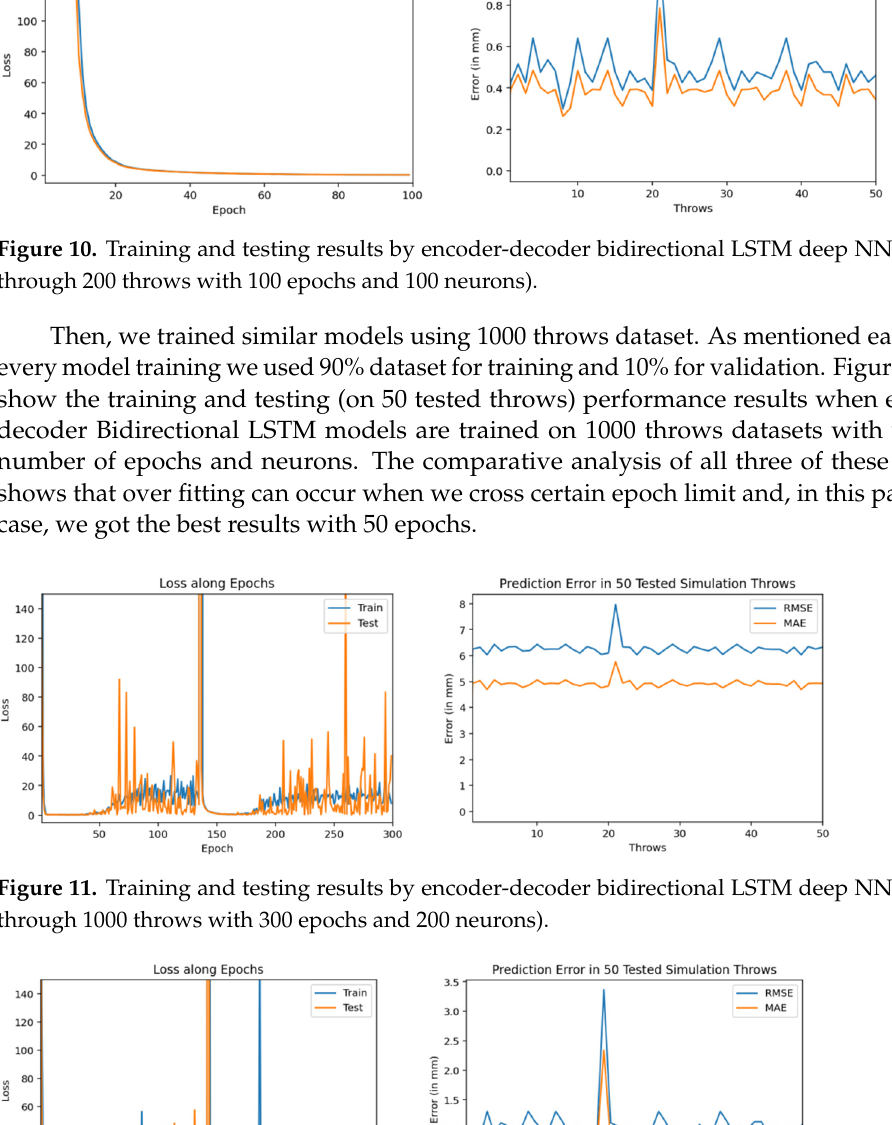
Figure 13. Training and testing results by encoder-decoder bidirectional LSTM deep NN (trained through 1000 throws with 50 epochs and 100 neurons).